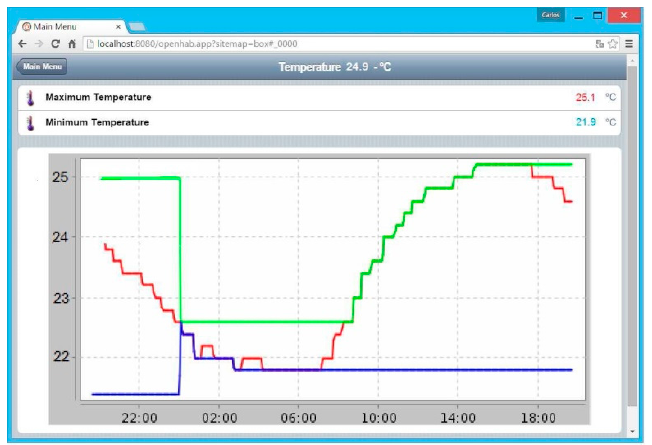
Figure 12. Screenshot of the exemplary variation of temperature inside the transport box. Current value (red), minimum value (blue), maximum value (green).